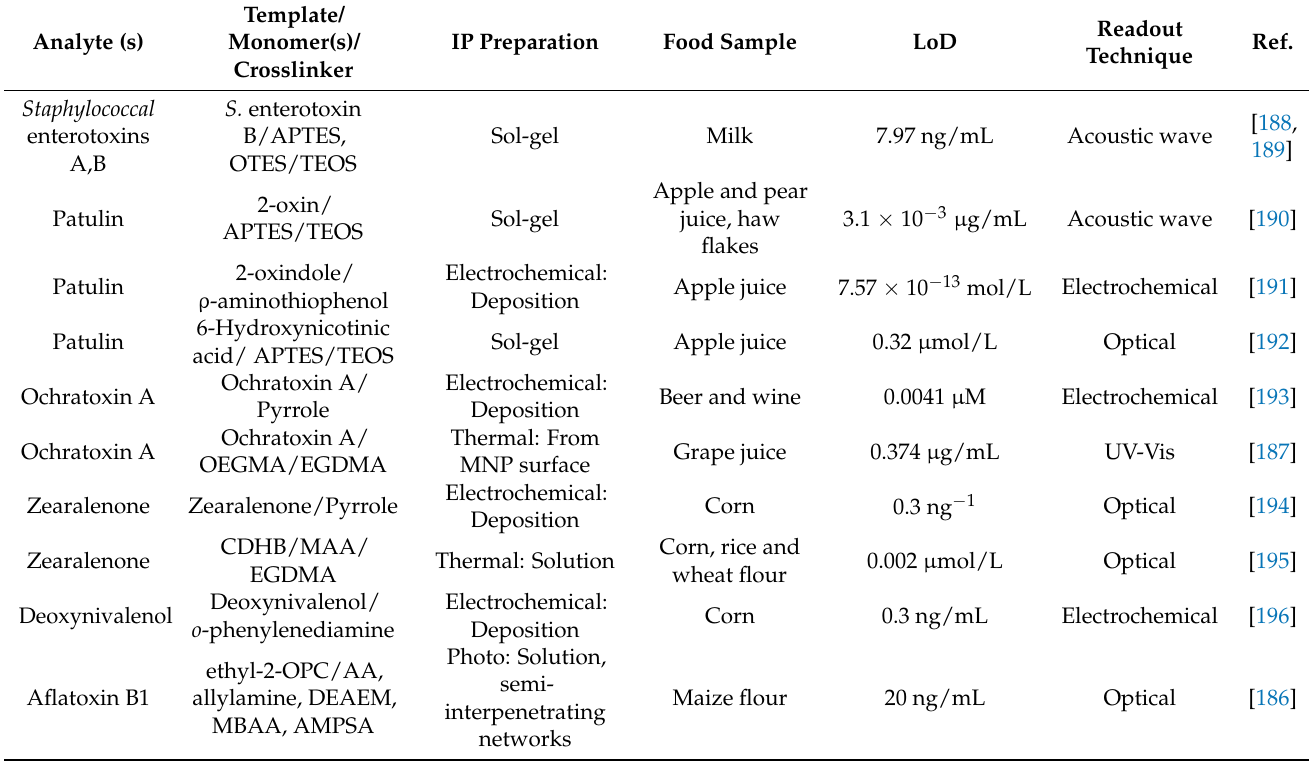
Figure 3. Schematic representation of synthesis of imprinted polymer on magnetic nanoparticles surface. TEM images of: ( i ) functionalized nanoparticles; and ( ii ) imprinted polymer magnetic nanoparticles. Reprinted from [187]. Copyright (2016), with permission from Elsevier. Table 4. Summary of recent publications for the recognition of toxins using IPs in food samples.